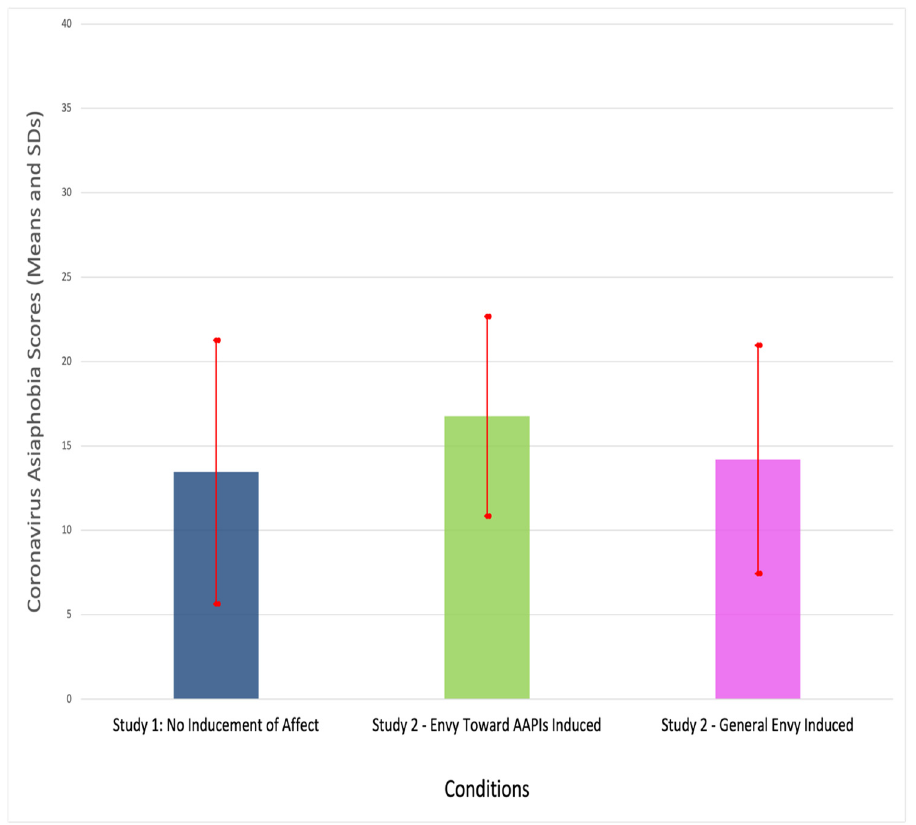
Figure 1. Mean Coronavirus Asiaphobia scores across three conditions and corresponding standard deviations.